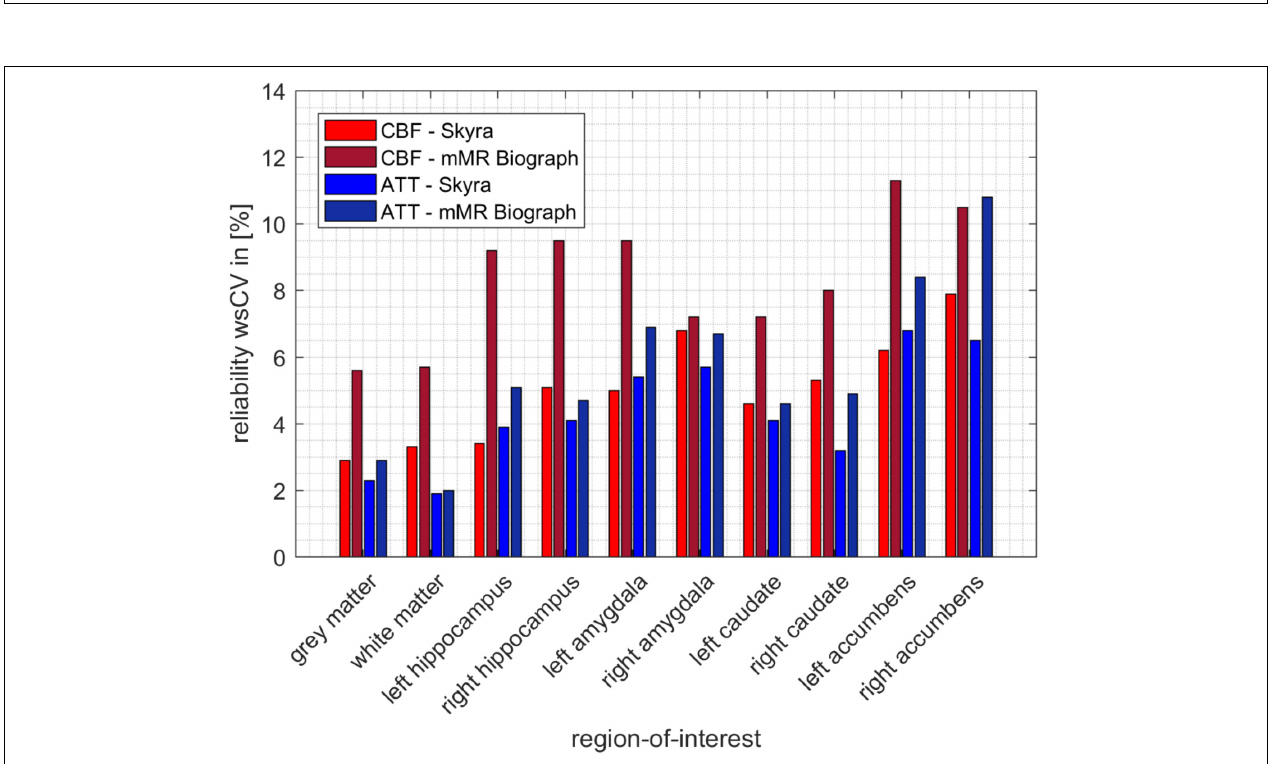
FIGURE 3 | Visualized reliability of CBF (red) and ATT (blue) estimated from pCASL acquisitions (from Skyra and mMR Biograph) for several region-of-interests. Corresponding within-subject coefficients of variation (wsCV) values are listed in Table 2 .